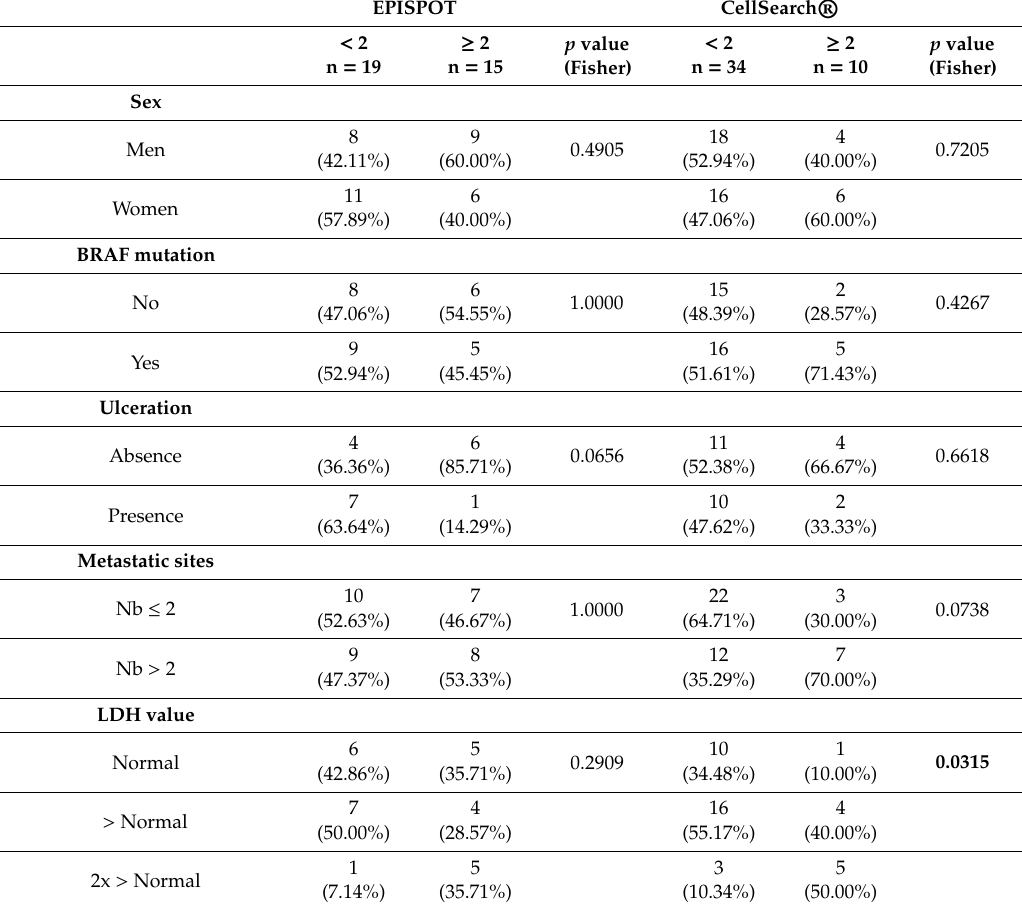
Table 3. Clinical characteristic of patients with metastatic melanoma in function of CTC detection with the S100-EPISPOT and CellSearch ®